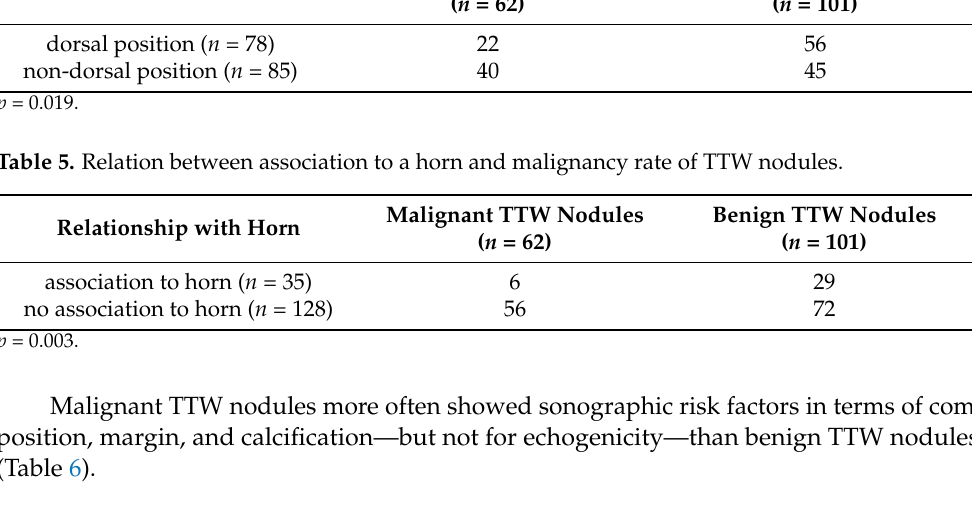
Table 6. Sonographic features in malignant and benign TTW nodules. Malignant TTW Benign TTW Category Nodules ( n = 62) Nodules ( n = 101) % % composition solid 96 85 mixed 4 14 cystic 0 1 echogenicity hypoechoic 85 65 isoechoic 15 hyperechoic 0 anechoic 0 margin smooth 22 75 lobulated/irregular/ill-defined 78 25 calcification none 31 62 microcalcification 51 20 other 18